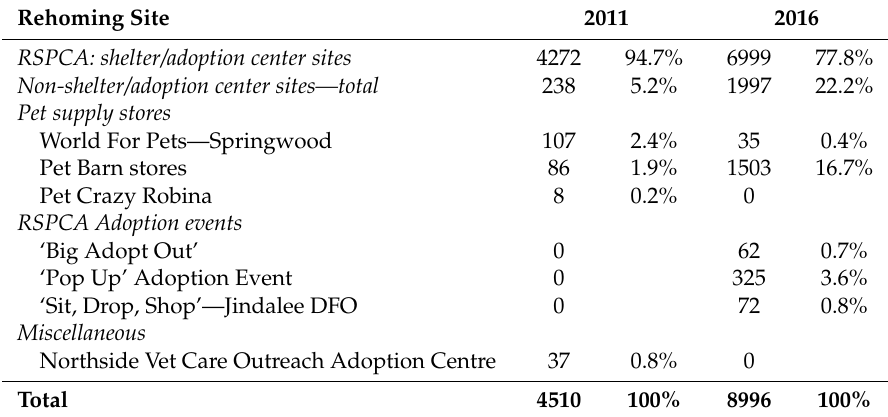
Table A5. Numbers of admissions to RSPCA in which the cat was rehomed by day 90 of admission by site that cat was rehomed from in 2011 and 2016. Within year of admission, percentages are expressed as proportions of the total number of admissions where the cat was rehomed by day 90 of admission (4510 and 8996 in 2011 and 2016,